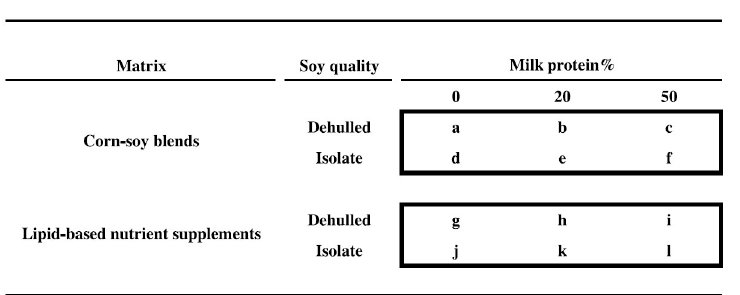
Fig 1. Experimental food supplements. The 2 × 2 × 3 factorial design, showing the 12 experimental food supplements based on CSBs or LNS, with either dehulled soy or soy isolate and with 0%, 20%, or 50% of total protein from milk. Two supplements correspond to currently used products: “a” (CSB+) and “b” (CSB++). Product “i” is similar to Plumpy’Sup, containing dehulled soy but with dry skimmed milk instead of whey. CSB, corn–soy blend; LNS, lipid- based nutrient